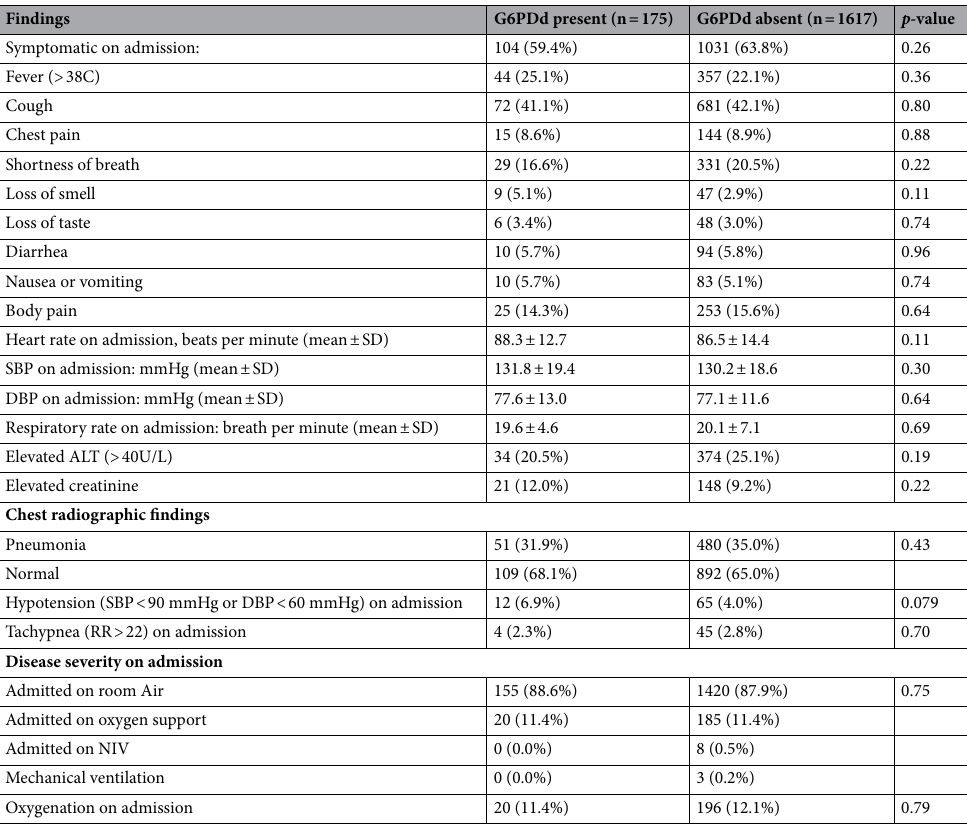
Table 2. Findings upon admission in the study subjects. ALT alanine aminotransferase, NIV non-invasive ventilation.